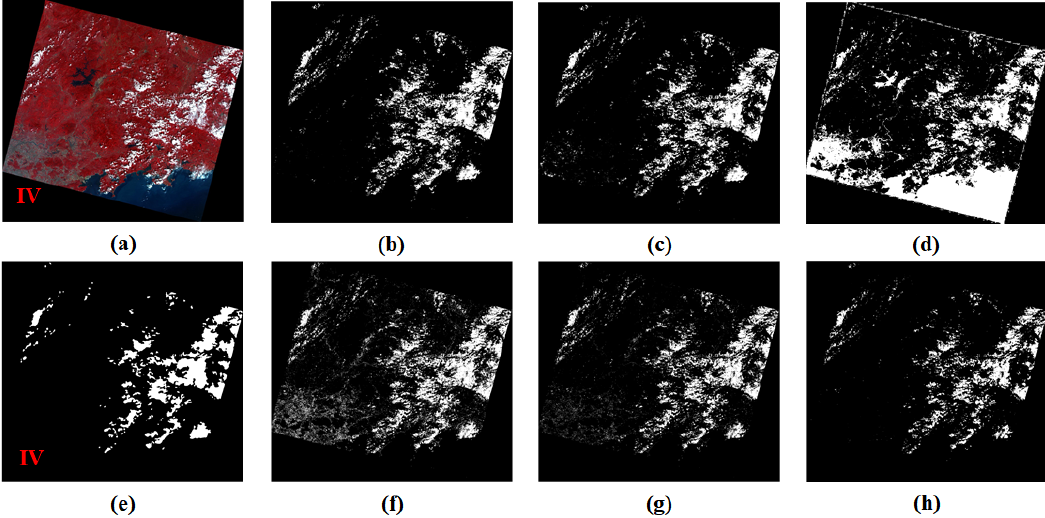
Figure 7. Cloud detection maps of the compared methods: ( a ) Input images labeled IV from the GF-1 WFV dataset, ( b ) reference detection map, ( c ) proposed, ( d ) K-means, ( e ) PRS, ( f ) PCANet, ( g ) SVM, and ( h ) SL. Table 2. The detection performance of different methods on Images III and IV from the GaoFen-1 (GF-1) wide field of view (WFV) dataset. The bold fonts indicate the best results. Image III Proposed K-means PRS PCANet SVM SL AUC